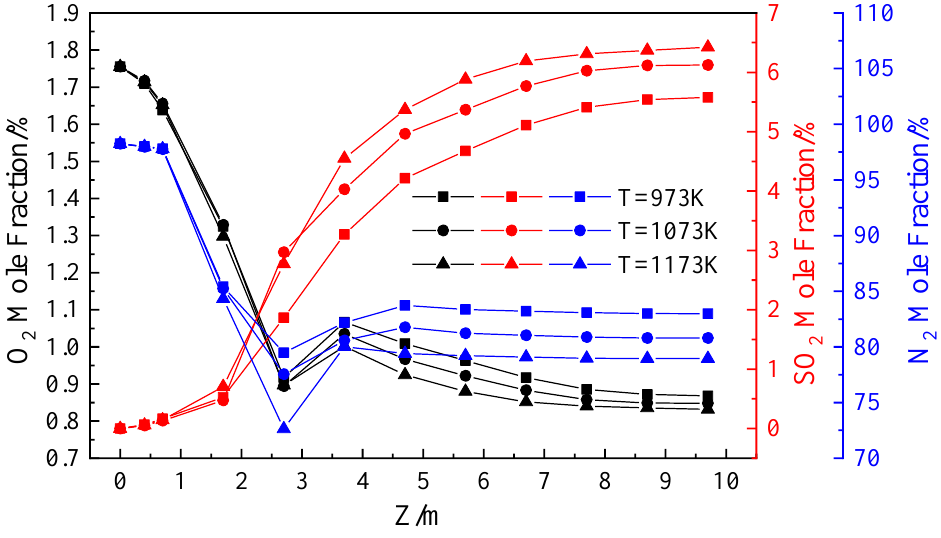
Figure 16. Curve of average molar fraction of gas phase at each section in the Z-axis of different flue gas temperatures.